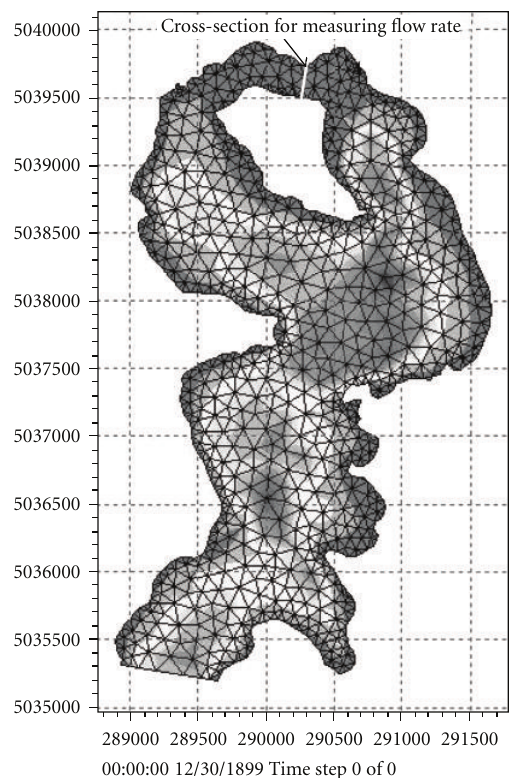
Figure 9: The mesh without including the causeway; the white straight line at the location of the existing causeway indicates a cross-section location where the total amounts of the simulated passing through flows are calculated.